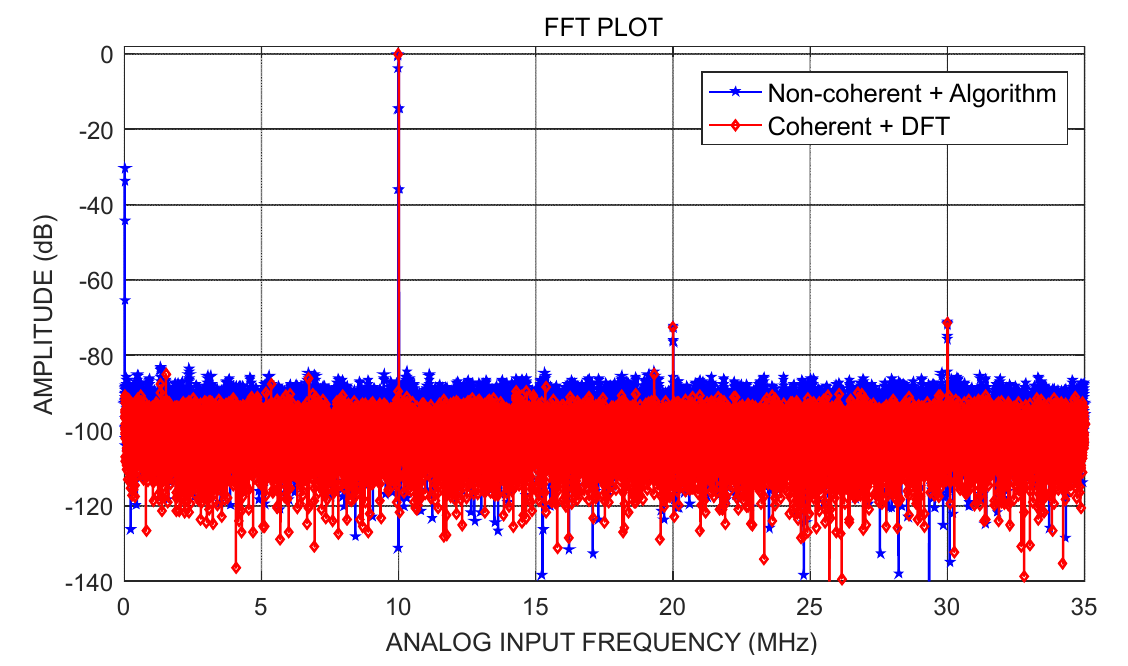
Figure 11. Spectrogram of AD9230 test data.